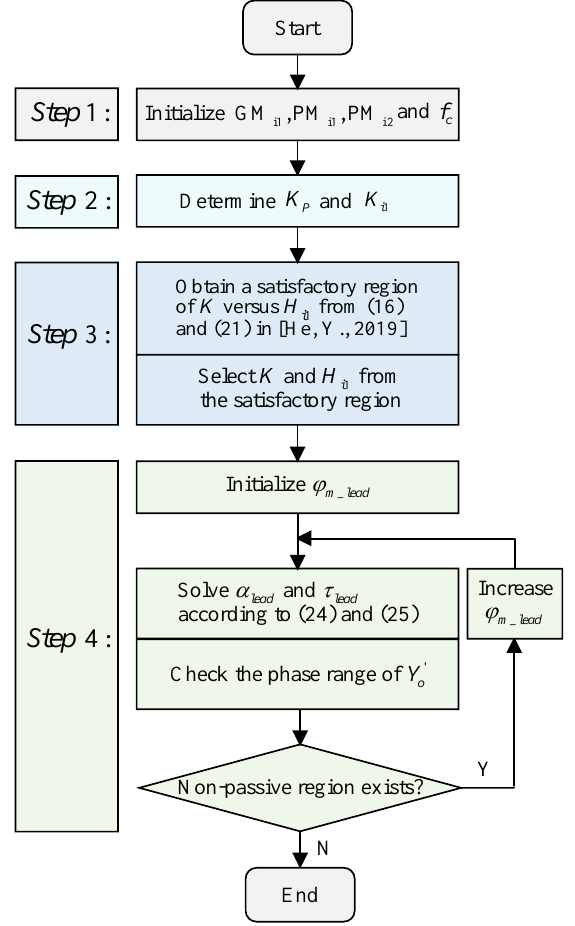
Figure 14. Flowchart of the proposed passivity enhancement